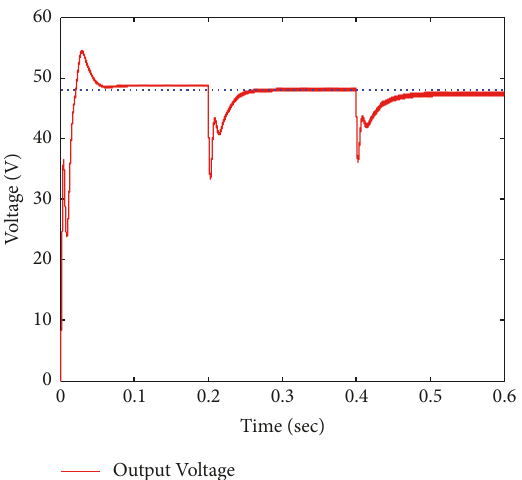
Figure 13: Output voltage at the common dc bus.